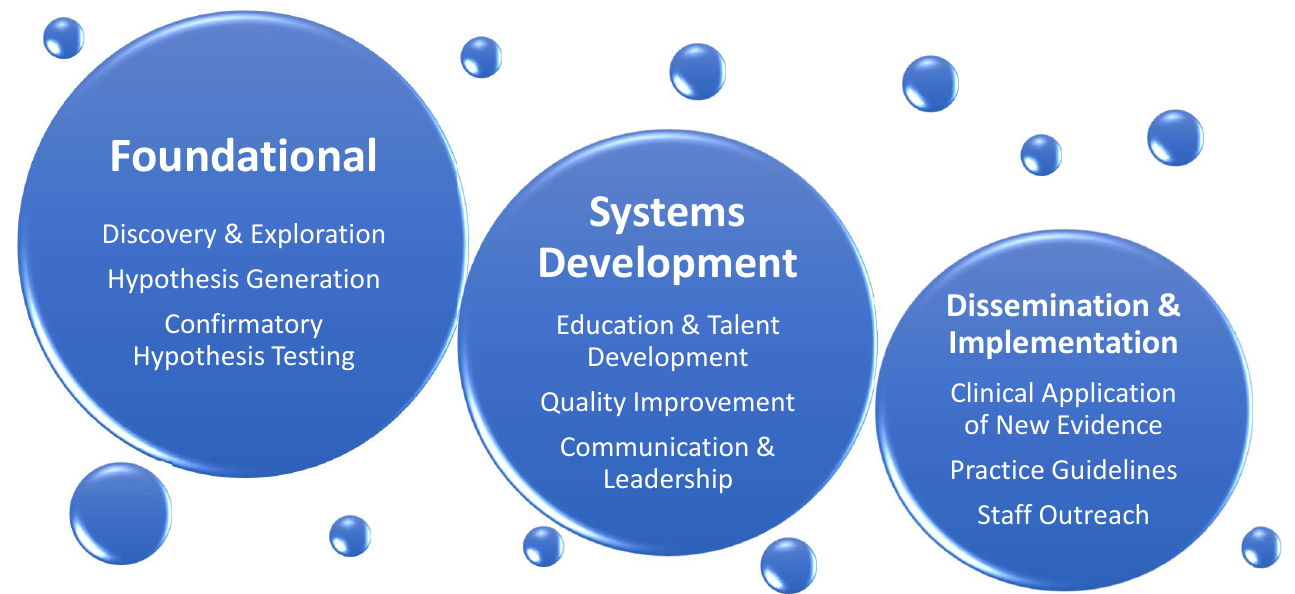
Figure 3. General Categories of Research Needed to Advance Cardiothoracic Surgical Critical Care Medicine. The expansion of knowledge in the field will depend on strong foundational research concentrating on basic science, resulting in new discoveries, hypothesis generation, and confirmatory testing. Concomitantly, inquiry and investigation of educational, quality and systems development studies need to be followed by dissemination and implementation research, where knowledge obtained from other two categories can be translated into clinical practice. Table 2 List and Summary of Publications Important to Cardiothoracic Surgical Critical Care Medicine.